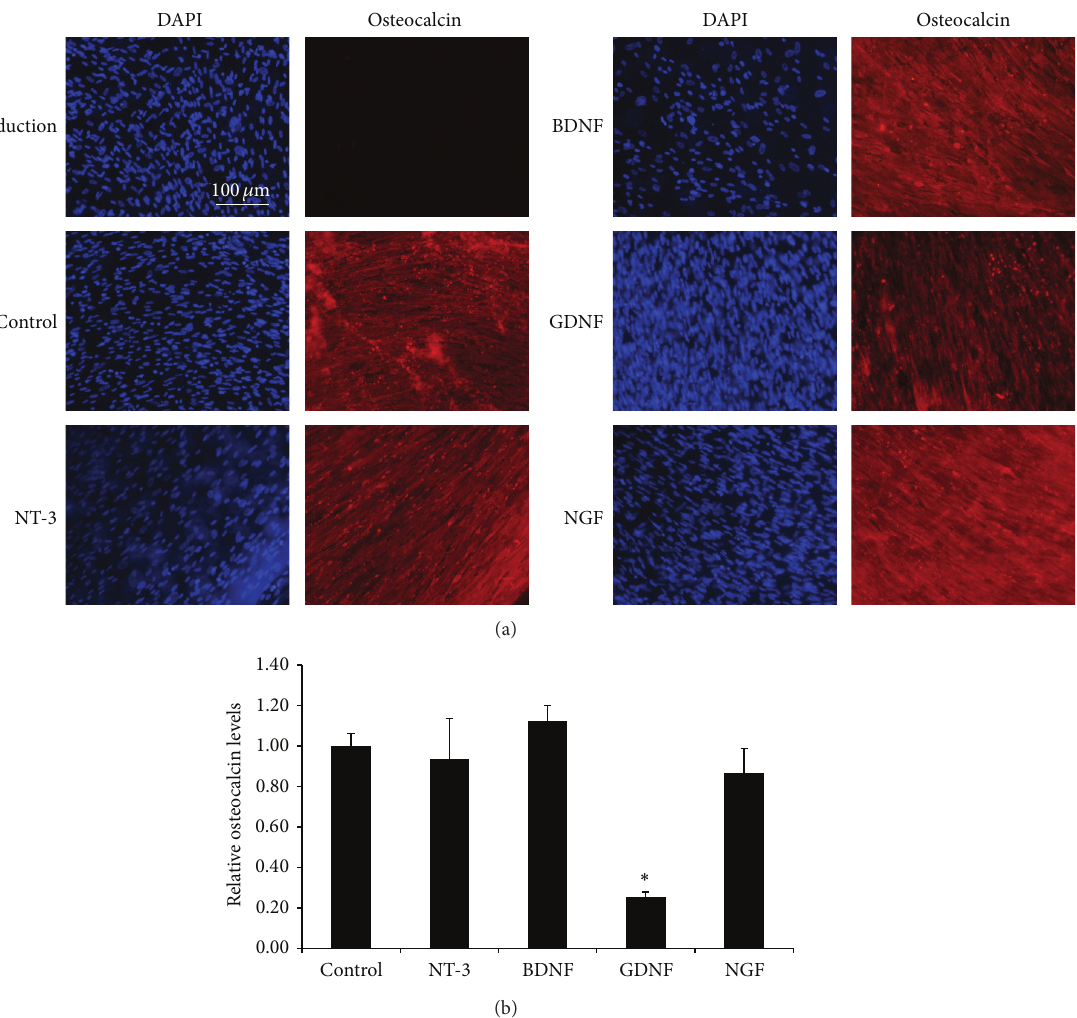
Figure 5: The effect of overexpression of NTFs on the osteogenic differentiation of MSCs. Transduced MSCs were cultured in osteogenic induction medium for 21 days. (a) Cells were stained with anti-human osteocalcin antibody and pictured in representative areas. Scale bar = 100 𝜇 m. (b) Relative osteocalcin levels. ∗ 𝑃 < 0.05 versus control ( 𝑛 = 6